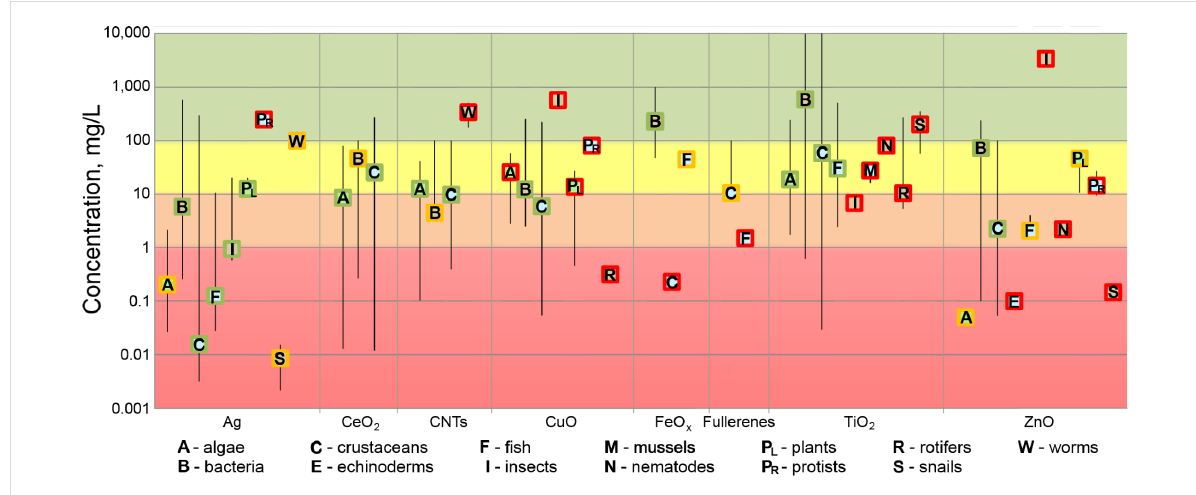
Figure 6: NanoE-Tox database: toxicity of selected nanoparticles to different organisms (data filtered by keyword ecotoxic*). Median E(L,I)C 50 values ± minimum and maximum values. Colours of the frames surrounding the letters indicate the number of papers from which the respective data origi- nates: red = 1 paper, orange = 2 papers, green ≥ 3 papers. The whiskers indicate the variability of the data. Note the logarithmic scale of y-axis. The E(L,I)C 50 values used to derive the median values are from 113 papers and usually based on nominal concentration of the compound [44,55,56,61,64-172]. The toxicity ranking is indicated with the coloured background: E(L)C 50 ≤ 1 mg/L – acutely very toxic, potentially chronically very toxic (red); E(L)C 50 >1 to ≤ 10 mg/L – potentially chronically toxic (orange); E(L)C 50 > 10 to ≤ 100 mg/L – potentially chronically harmful (yellow); E(L)C 50 > 100 – not classified (green). The database entries were selected based on bibliometric data search in Thomson Reuters WoS TM using the keywords as indicated in Table 1 as of January 6, 2015.